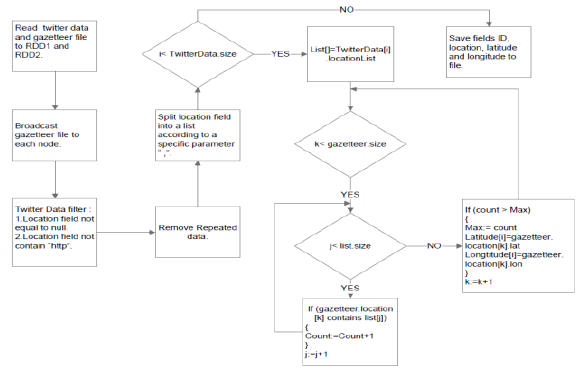
Figure 1. Workflow and algorithm to complete the geocoding procedure based on twitter user profile and gazetteer